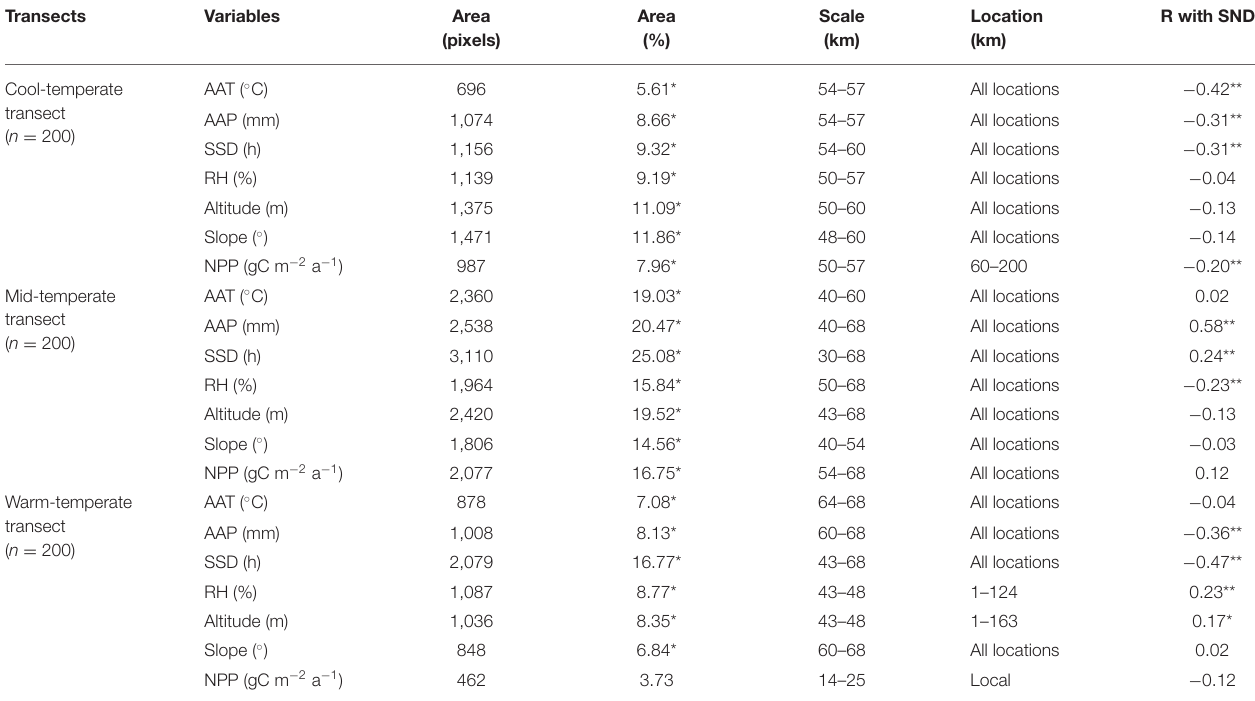
TABLE 3 | The percentage area of significant partial wavelet coherence (PAS PWC ) between temporal changes of soil nitrogen density (SND T ) and influencing factors and the partial correlation coefficients (R) between SND T and influencing factors. Transects Variables Area